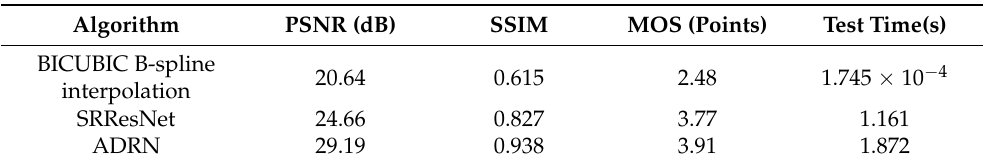
Table 7. Comparison of the mean results of evaluation indexes and test time for the three algorithms on the test